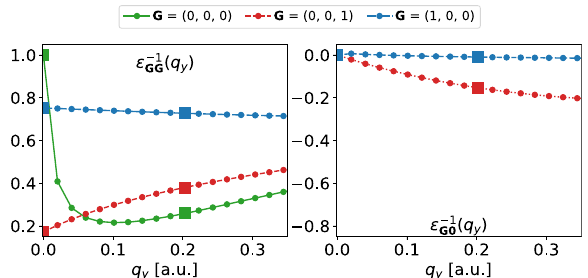
Fig. 1 Selected elements of the real part of the static inverse dielectric matrix of MoS 2 . Diagonal and wing elements elements are plotted in the left and right panel respectively. Squares indicate values obtained with a 6 × 6 × 1 grid, while dots with a 60 × 60 × 1